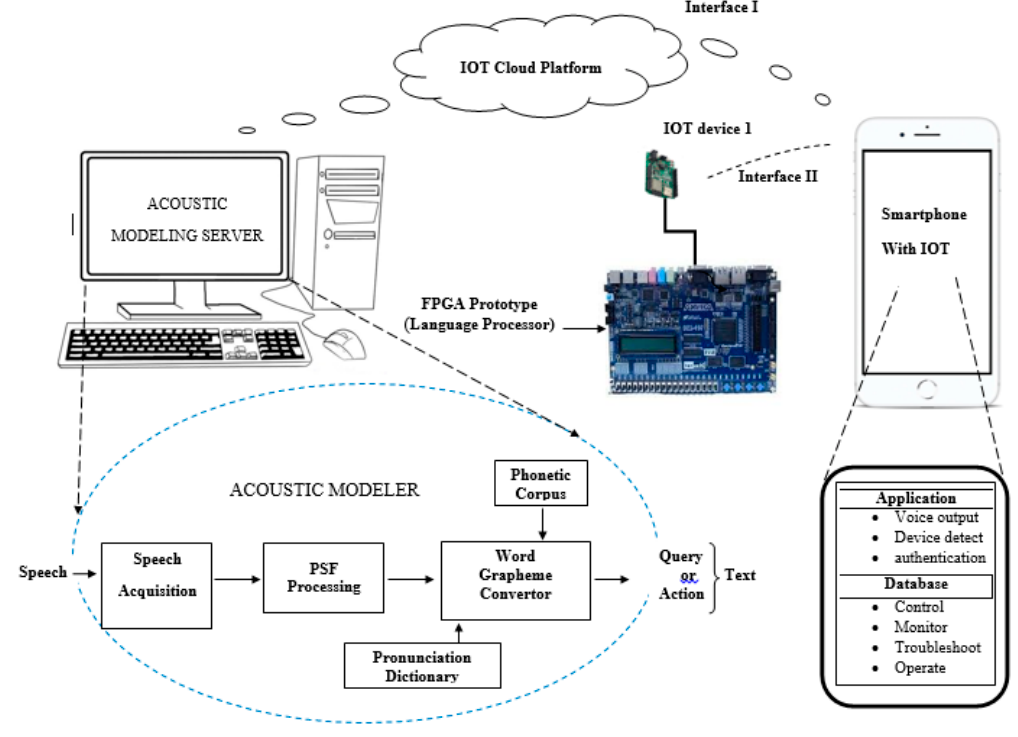
Figure 1. Smart device troubleshooting system.